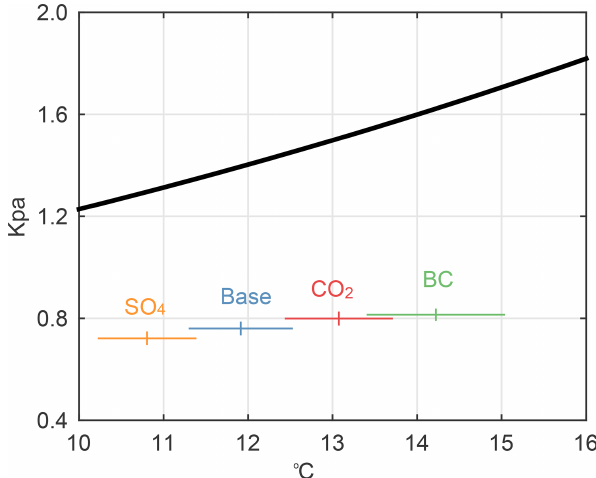
Figure 5. Domain-averaged vapor pressure changes per unit forc- ing as a function of temperature at 850hPa for Europe. Error bars indicate 1 standard error across the models. The thick black line represents saturation vapor